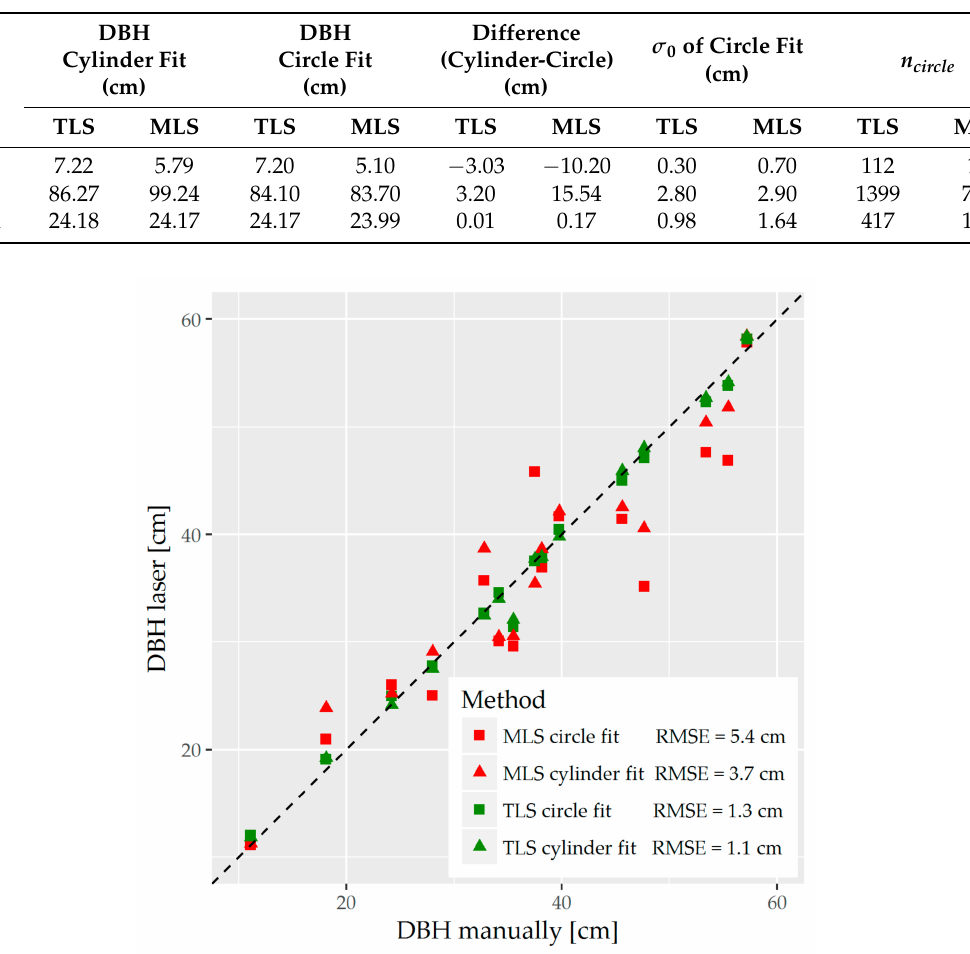
Figure A2. DBH (cylinder and circle fit) determination of the MLS and TLS data in comparison with the manually measured diameters of plot